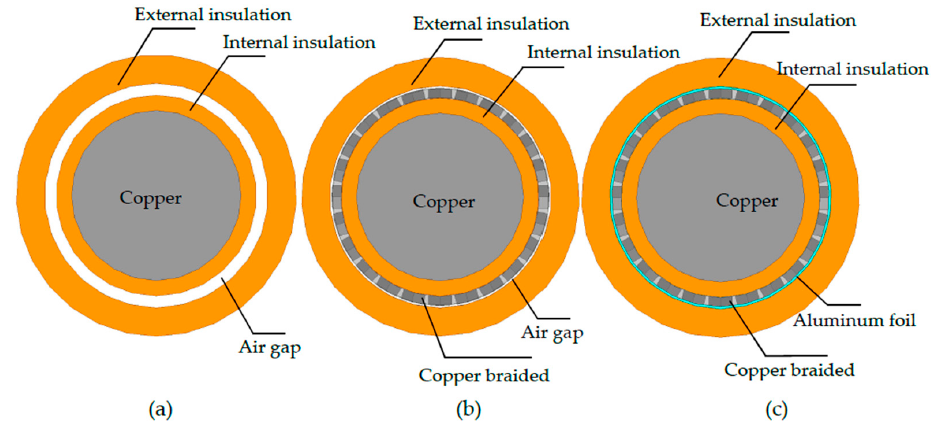
Figure 6. Cross sections: ( a ) unshielded cable; ( b ) single-shield cable; ( c ) double-shield cable.